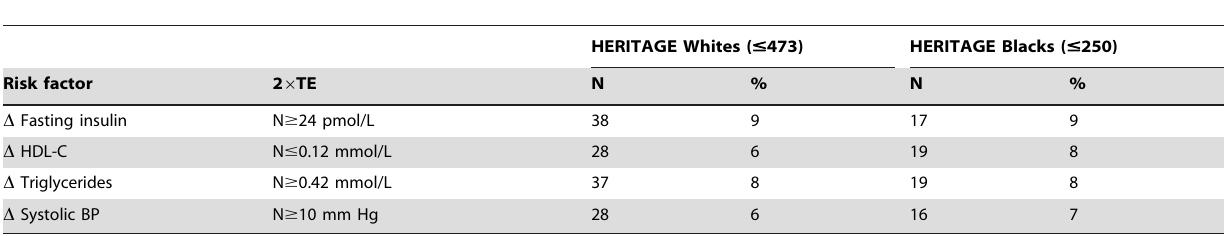
Table 4. Prevalence of Adverse Responders in